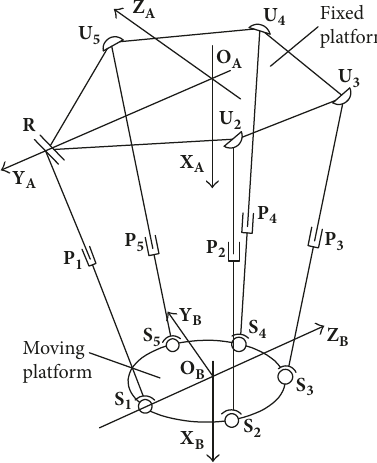
Figure 2: Coordinate system of 4-UPS-RPS parallel mechanism.